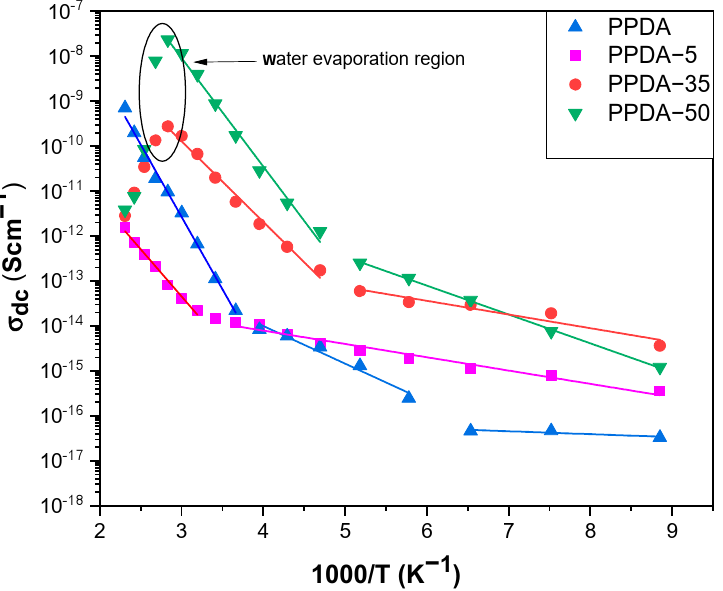
Figure 12. Variation in DC conductivity with reciprocal temperature. The solid lines represent fitting according to Arrhenius equation.